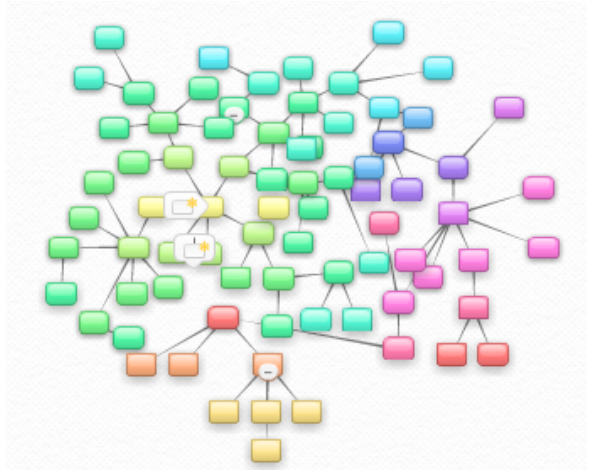
Figure 6. Chart used to map entities and attributes in RARM